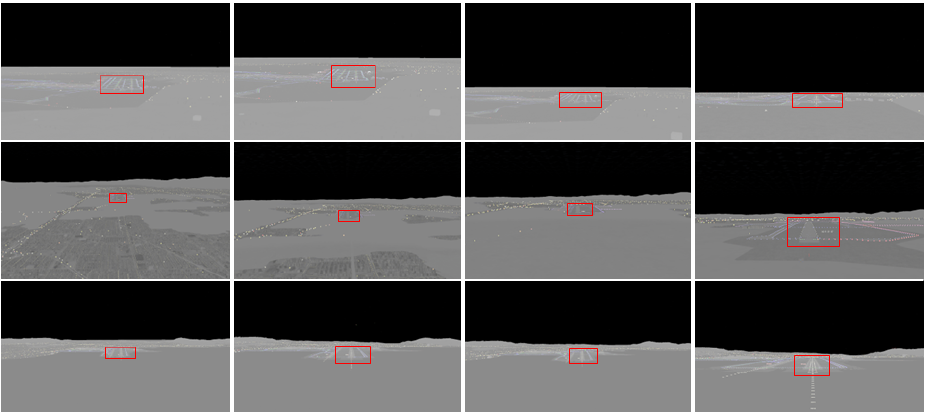
Figure 18. Runway detection results with improved anchor